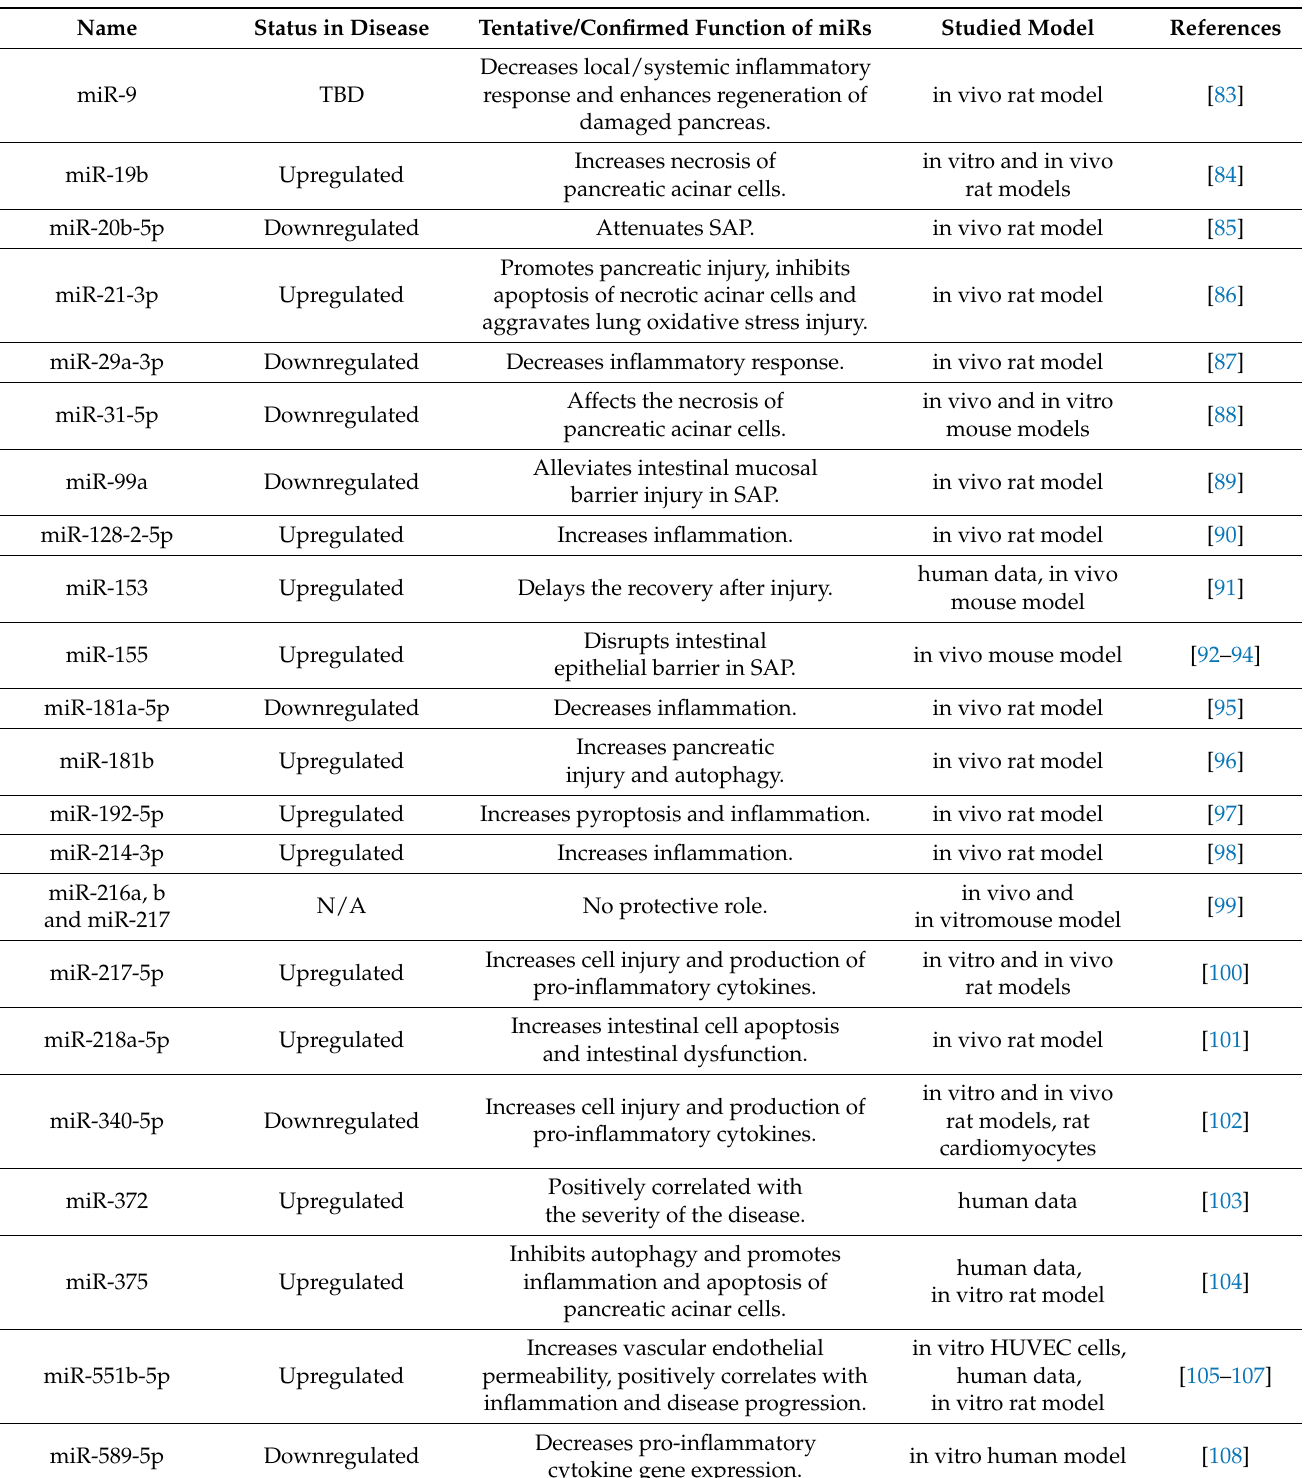
Table 2. Table summarizing the role of miRs in severe acute